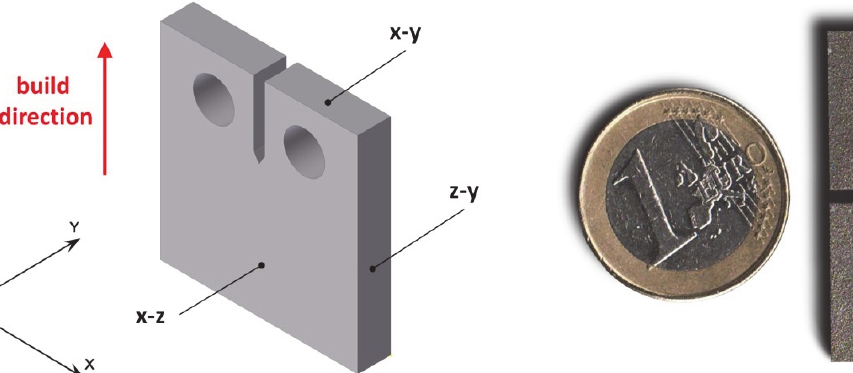
Figure 3: CT specimen orientation with respect to build direction.